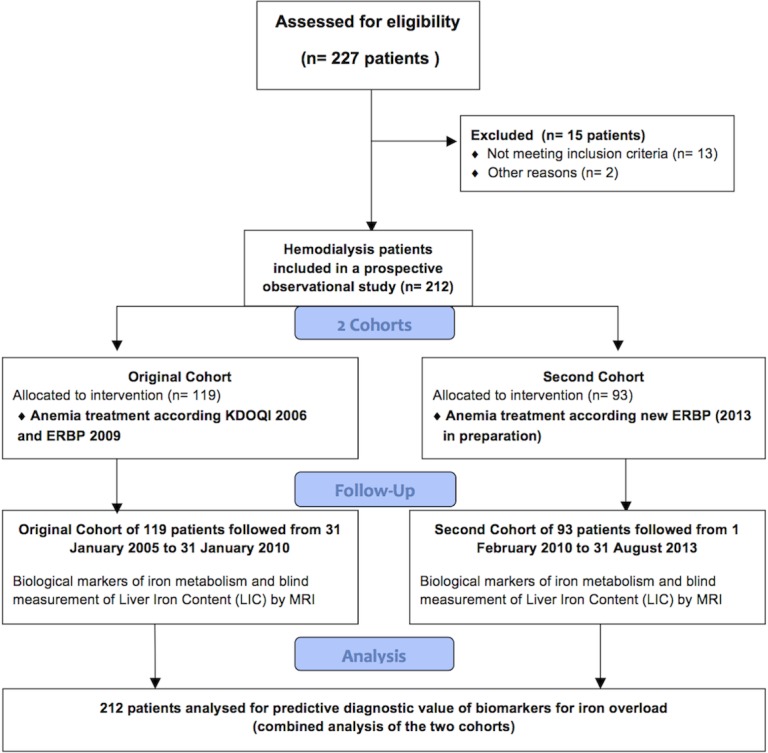
Consort flow Diagram.